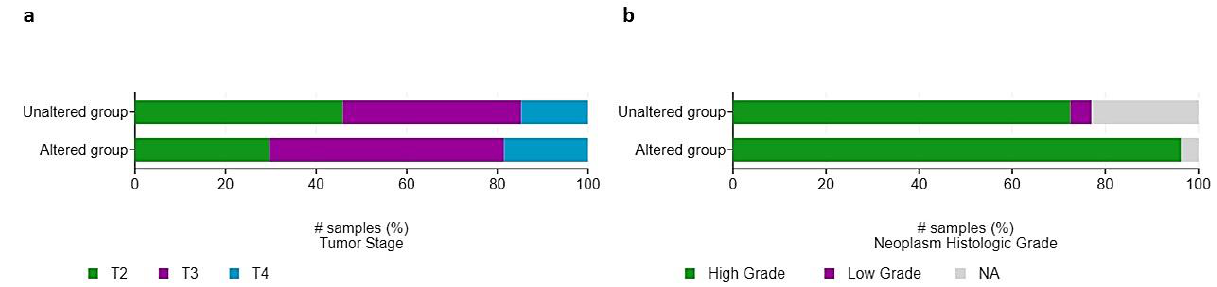
Figure 7. Distribution of ( a ) pathological T-stage and ( b ) grade among patients with HIF-2-altered and unaltered tumors. # Number of samples (%). Table 2. mRNA expression of genes enriched in HIF-2-altered tumors. µ : mean log2 gene expression, σ : standard deviation of log2 gene expression.